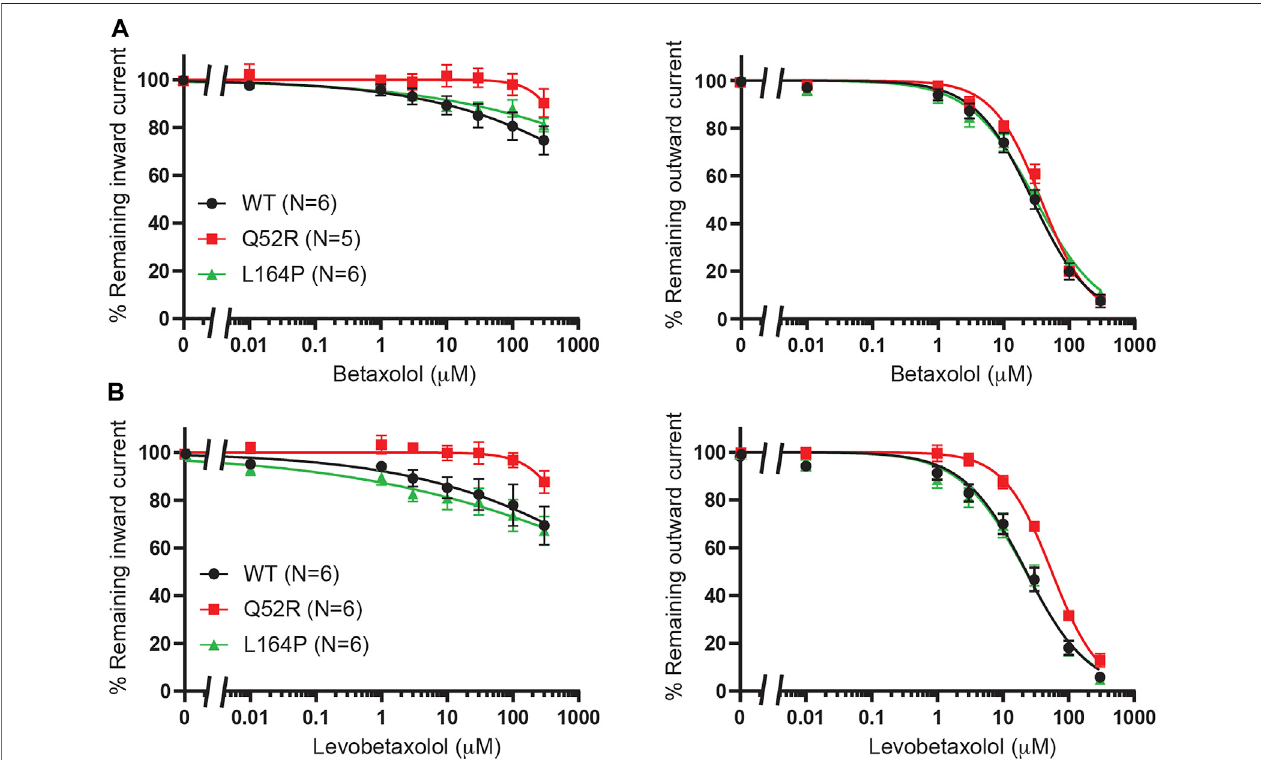
FIGURE 3 | Inhibition of Q52R and L164P K IR 6.2/SUR2a dependent current by betaxolol and levobetaxolol. IC 50 curves of K IR 6.2/SUR2a inward (at − 80 mV), left panels, and outward (at +50 mV), right panels, current inhibition in response to increasing concentrations of (A) betaxolol and (B) levobetaxolol. Wildtype K IR 6.2/SUR2a serves as control. Data were fi tted with Hill equation to estimate the IC 50 values. Data are shown as mean ± SEM. N depicts number of measurements on independent inside-out patches.